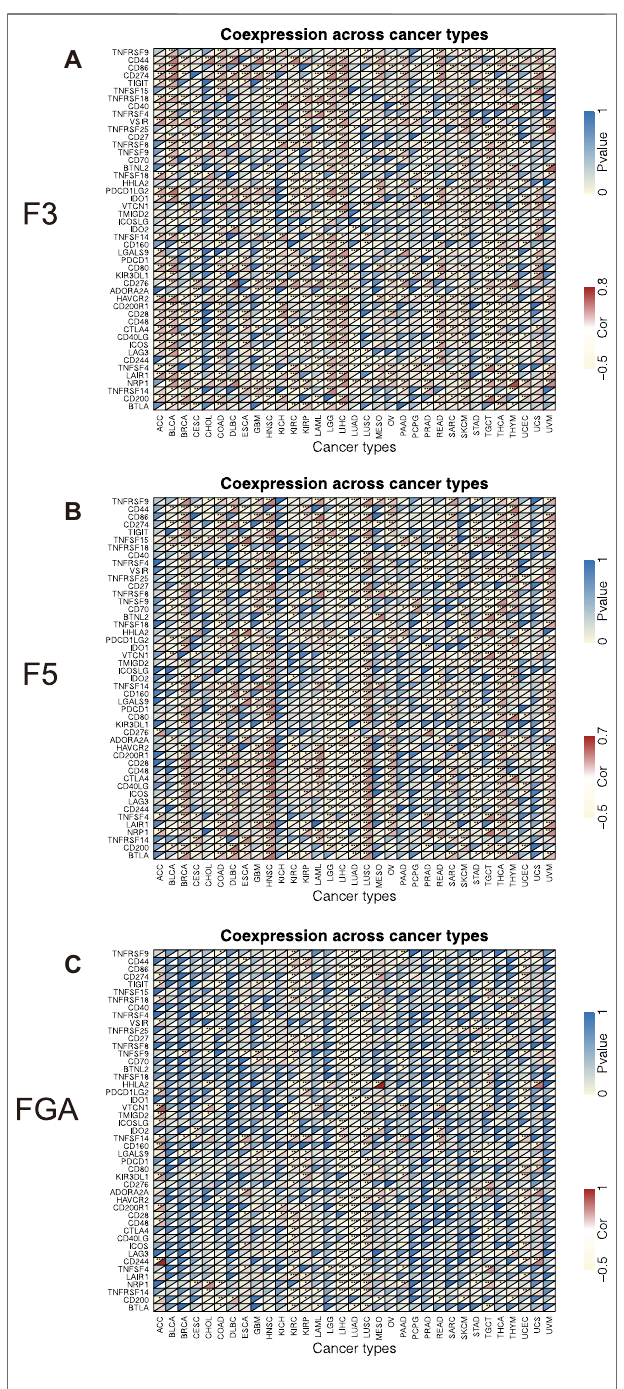
FIGURE 2 | Correlation between the expression of D-dimer-related genes and immune-related genes in TCGA cancers. (A – C) Correlation of F3, F5 and FGA with 47 immune-related